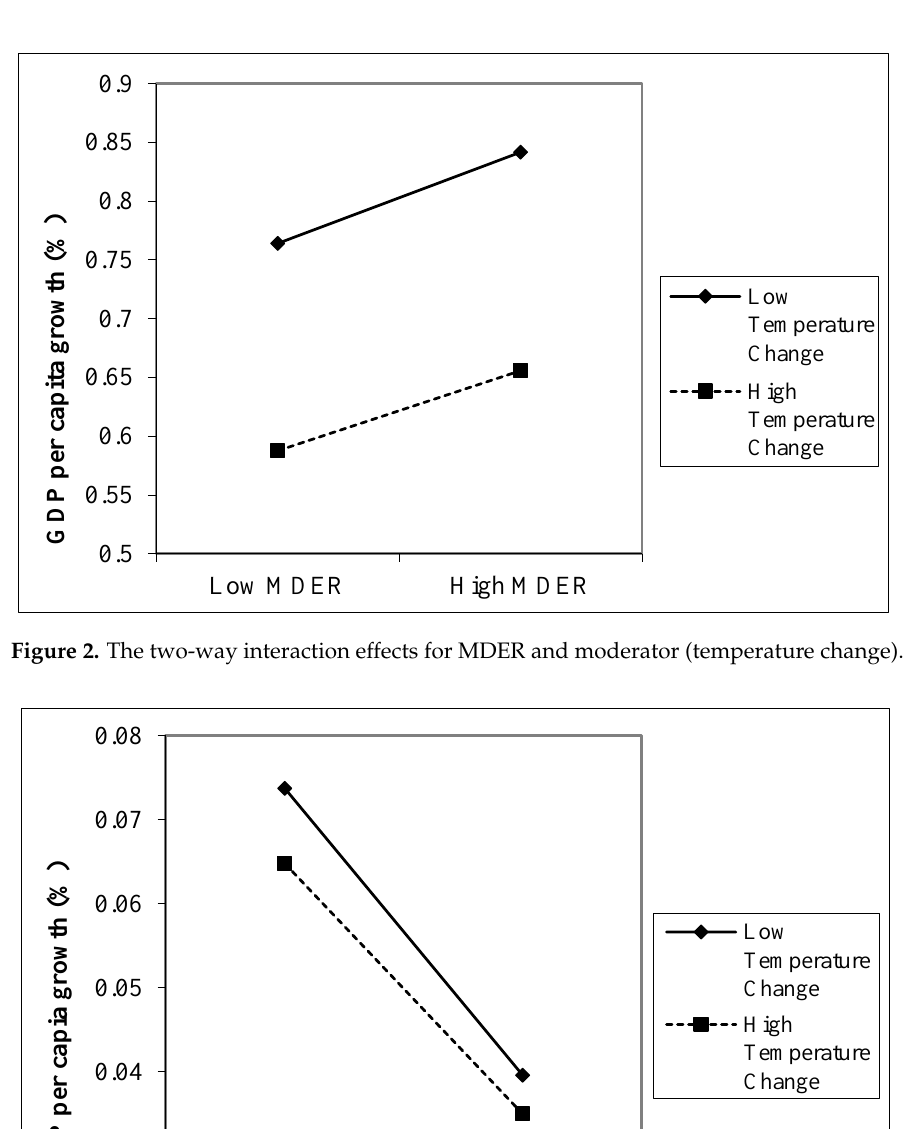
Figure 3. The two-way interaction effects for life expectancy and moderator (temperature change). Similarly, we found significant interaction effects between temperature change and life expectancy. Figure 3 shows that both increasing life expectancy and higher temperature change negatively affect productivity growth, i.e., growth is the smallest in countries where both temperature increases and life expectancy are relatively high. More interestingly, global warming seems to mitigate the negative effect of life expectancy on growth, indicated by the difference in slopes. Life expectancy has a weaker (negative) effect on growth if global warming